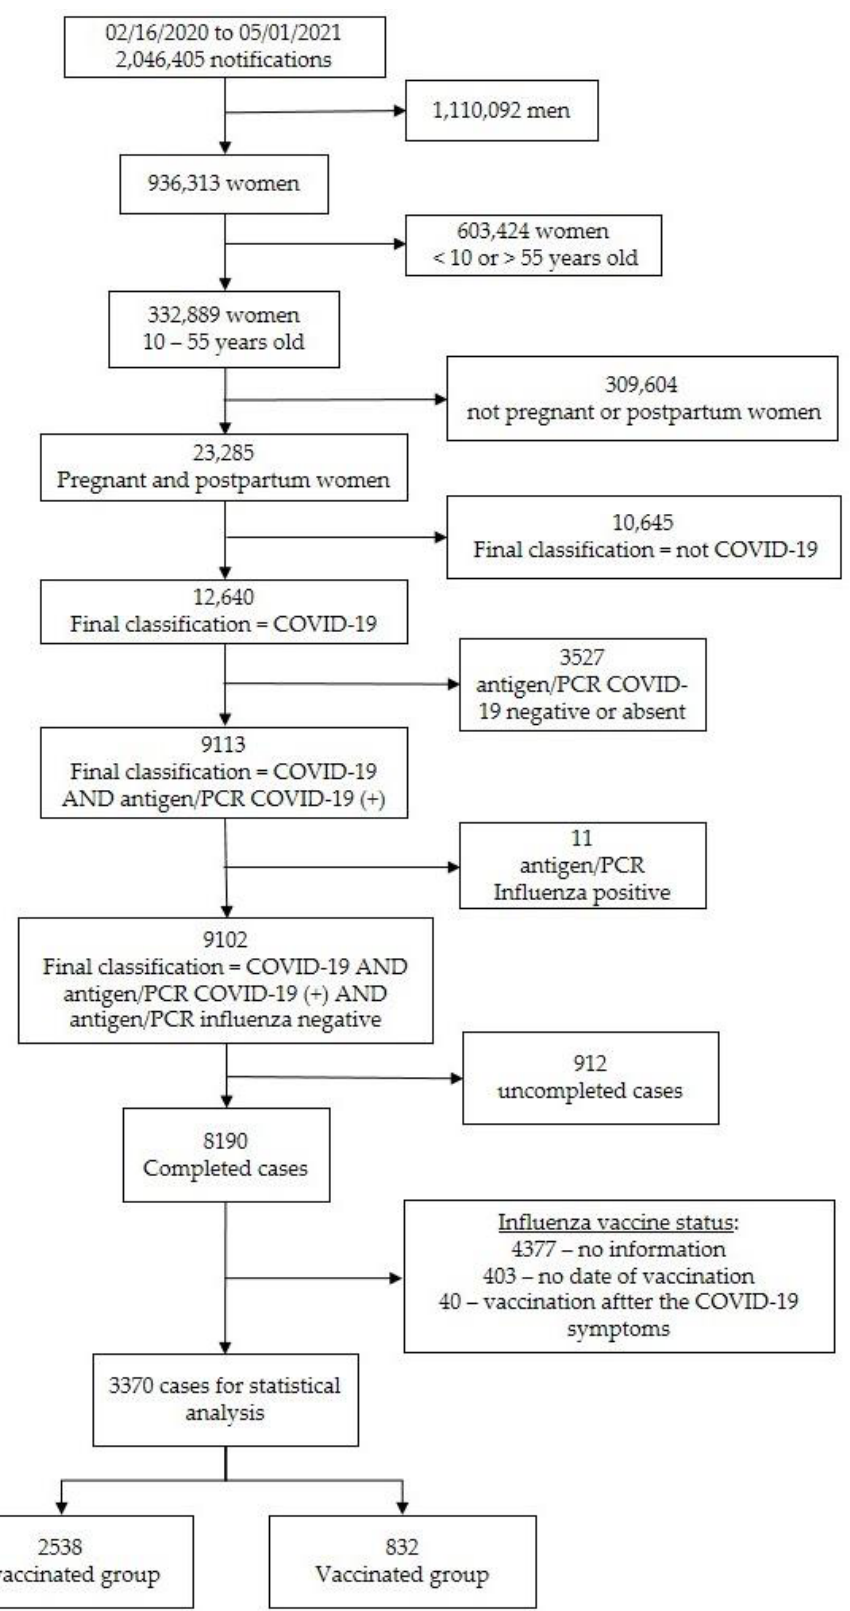
Figure 1. Flow chart depicting the enrollment process, explaining how the final number of subjects was derived for evaluation.